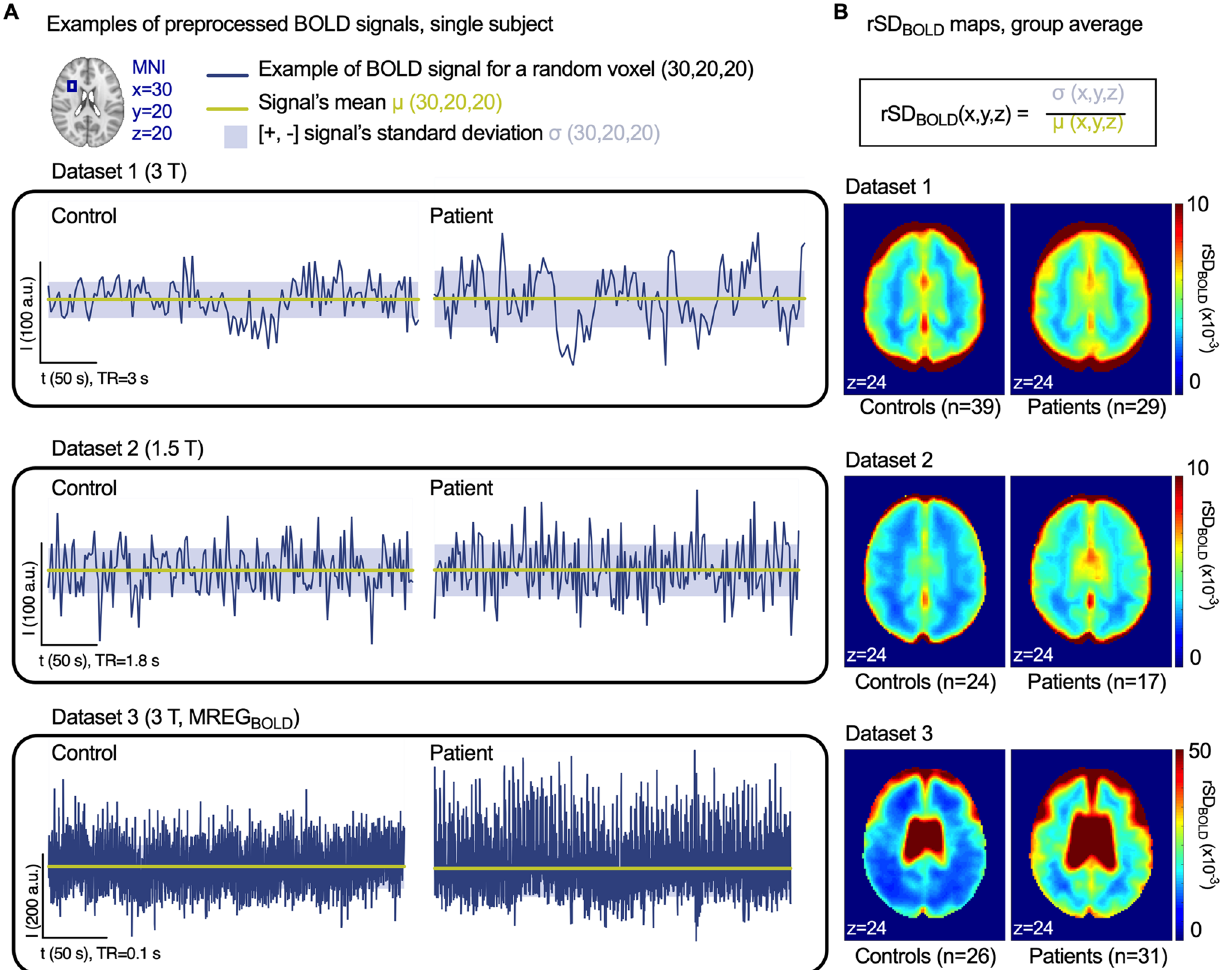
Figure 1. BOLD signal time series and formation of brain signal variability maps (rSD BOLD ) ( A ) Examples of random single voxel BOLD signals, the signal’s mean and standard deviation for control subjects and AD patients from each dataset. Location of the random region-of-interest in MNI coordinates is shown in the group mean brain maps ( B ). As a measurement of brain signal variability, we calculated rSD BOLD for each voxel and formed 3D